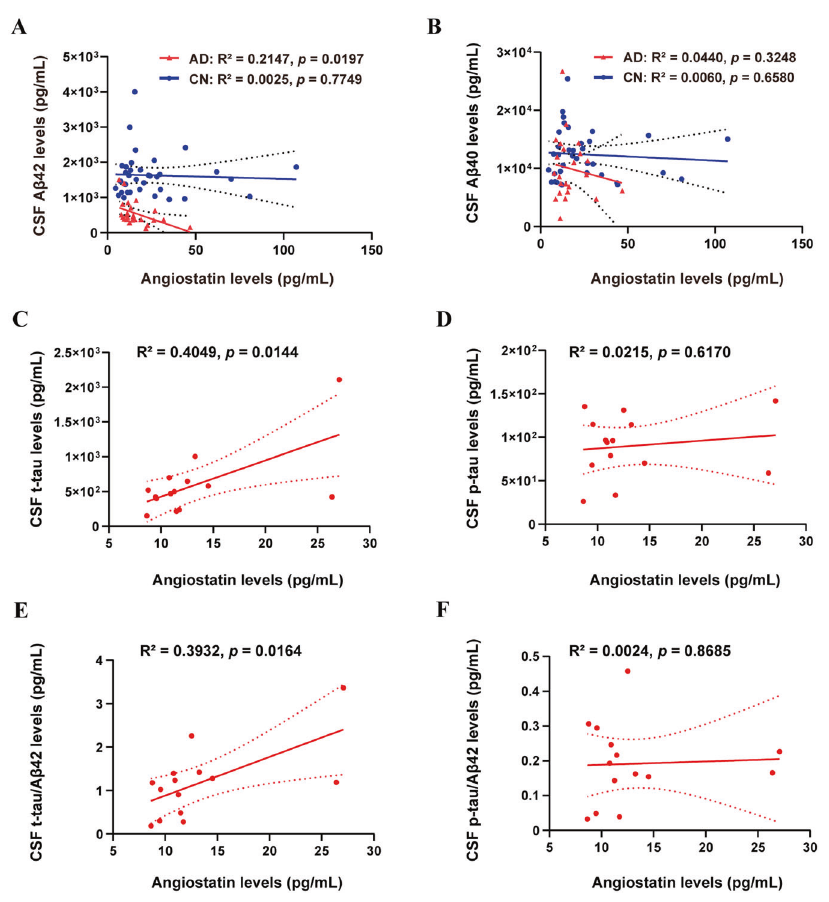
Fig. 3 Correlations between plasma angiostatin levels and CSF biomarkers. Correlations of angiostatin levels with CSF A β 42 levels ( A ) and A β 40 levels ( B ) in PiB-PET + AD dementia patients and cognitively normal controls (CN). Correlations of angiostatin levels with t-tau levels ( C ) and p-tau levels ( D ), t-tau/A β 42 ( E ), and p-tau/A β 42 ( F ) in PiB-PET + AD dementia patients with APOE- ε 4.